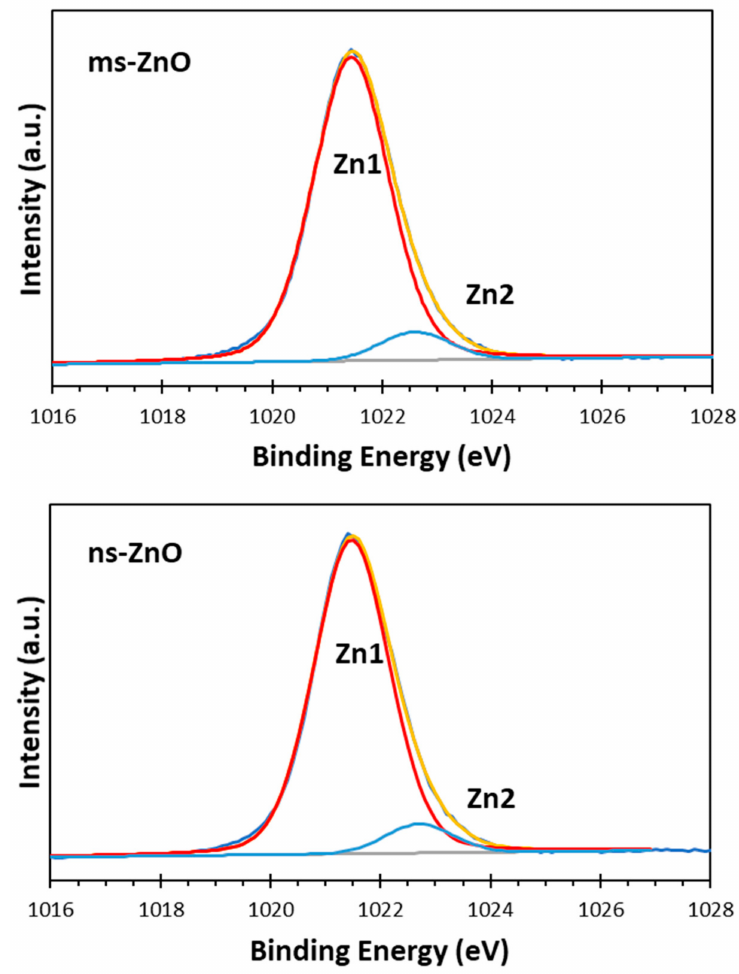
Figure 4. X-ray photoelectron spectroscopy (XPS) Zn 2p 3/2 spectra of ms-ZnO and ns-ZnO samples curve-fitted with two components corresponding to ZnO (Zn1) and Zn–OH species